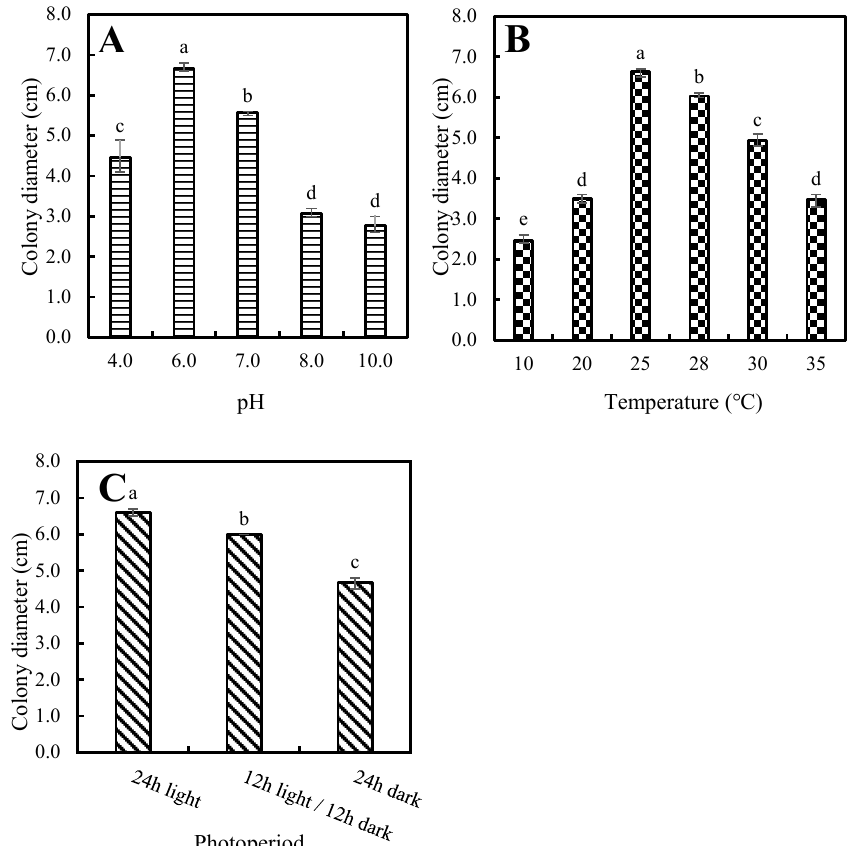
Figure 3. Colony diameters of ten Pythium aristosporum isolates at different treatments. ( A ) pH values. ( B ) temperatures. ( C ) photoperiods. The letters above the bars indicate significant difference for each isolate according to the least significant difference test ( p = 0.05).